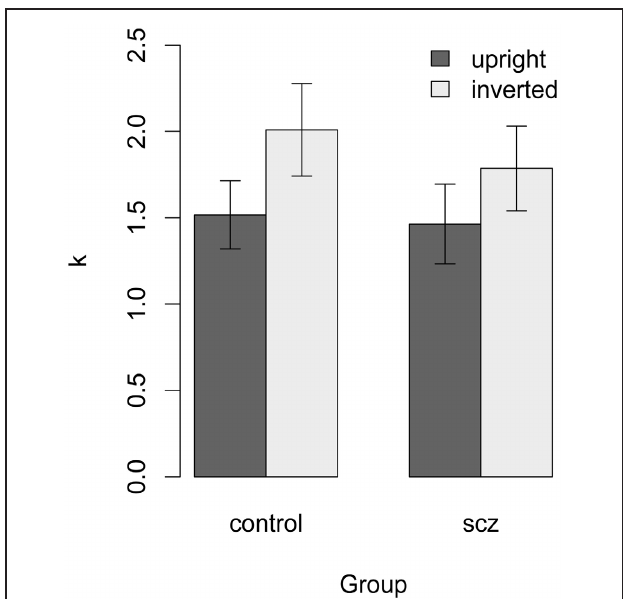
FIGURE 7 | Estimate of k for each participant with a higher threshold in the high-noise condition. In both groups, k was higher (i.e., calculation efficiency was lower) in the inverted face condition. The difference between the control and SCZ groups was not significant with face